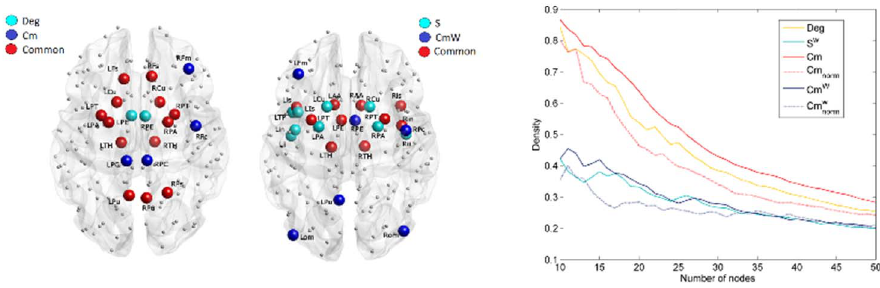
Fig. 2. Analysis of hubs and nodes with highest communicability. A) maps of the nodes with highest Deg and/or Cm. B) maps of nodes with highest S w and/or Cm w (normalized). The metric values for the nodes represented are at least one standard deviation (SD) over the average value. C) Density variation among the nodes with highest Deg, Cm, S w , Cm w .